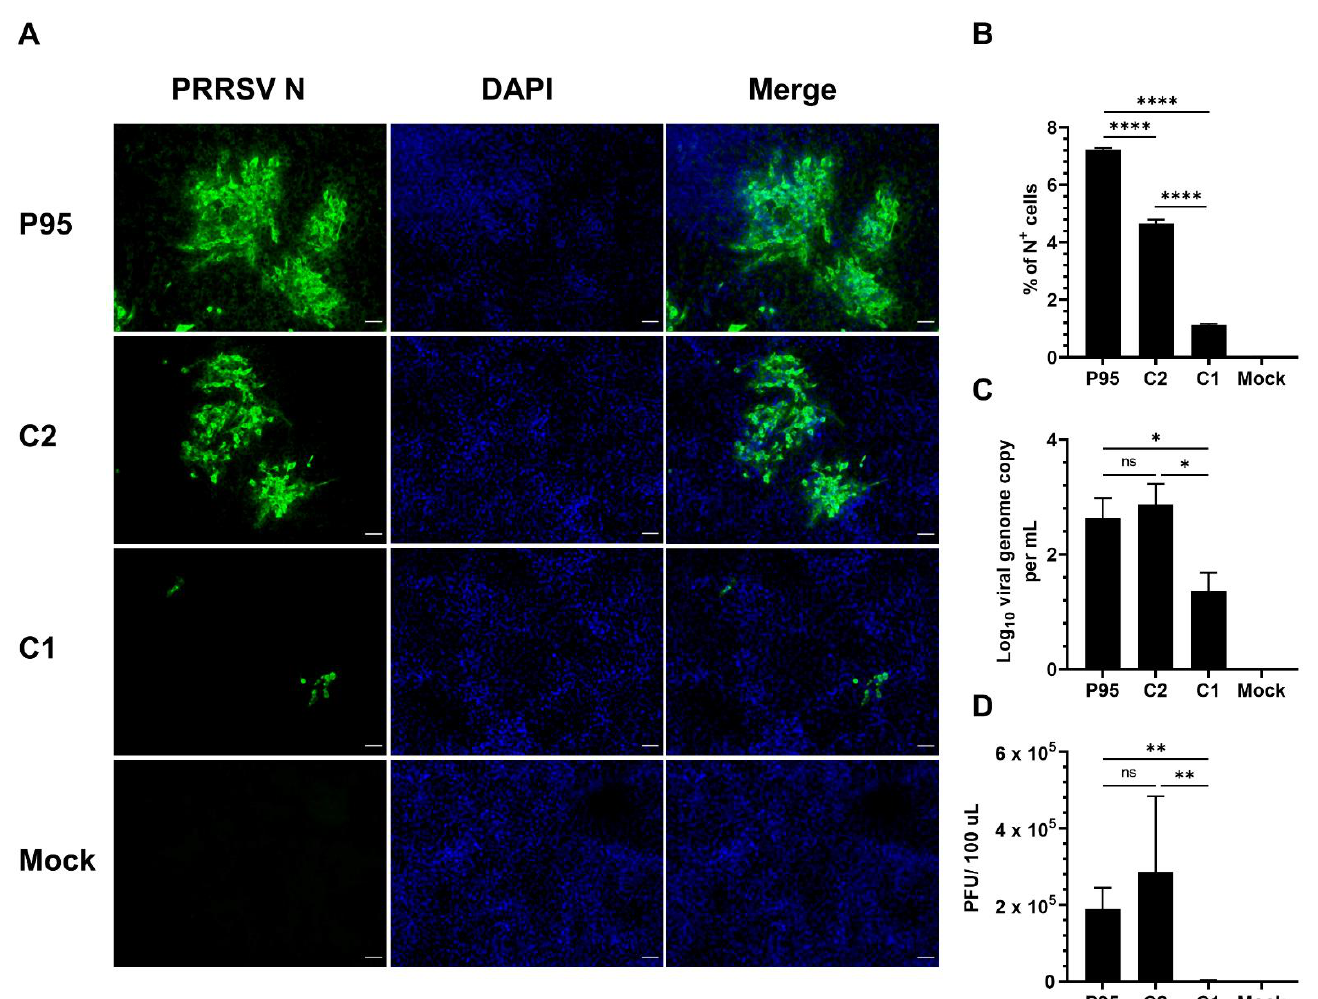
Figure 3. Infectivity of NCV1 P95 and its derived clones in PK15-pCD163 cells. PK15 cells stably expressing porcine CD163 (PK15-pCD163) cells were inoculated with NCV1 P95 and its derivatives C1 and C2 at an MOI of 10. Data were collected at 72 hpi. ( A ) Representative images of cells that were fixed and stained with an anti-N antibody to visualize virus-infected cells (green color). DAPI was used to stain the nuclei (blue color) . Scale bar = 50 μm. ( B ) Percentage of cells expressing N protein (N + ) as quantified by flowcytometry. ( C ) Difference of viral genome copy numbers in the culture supernatants collected at 0 hpi and 72 hpi as quantified by RT-qPCR. ( D ) Difference of virus infectious titers in culture supernatants collected at 0 hpi and 72 hpi as quantified by plaque assay in MARC-145 cells. Data are presented as means and SEM of the three independent experiments. ns: non-statistically significant, * p < 0.05, ** p < 0.01, **** p <